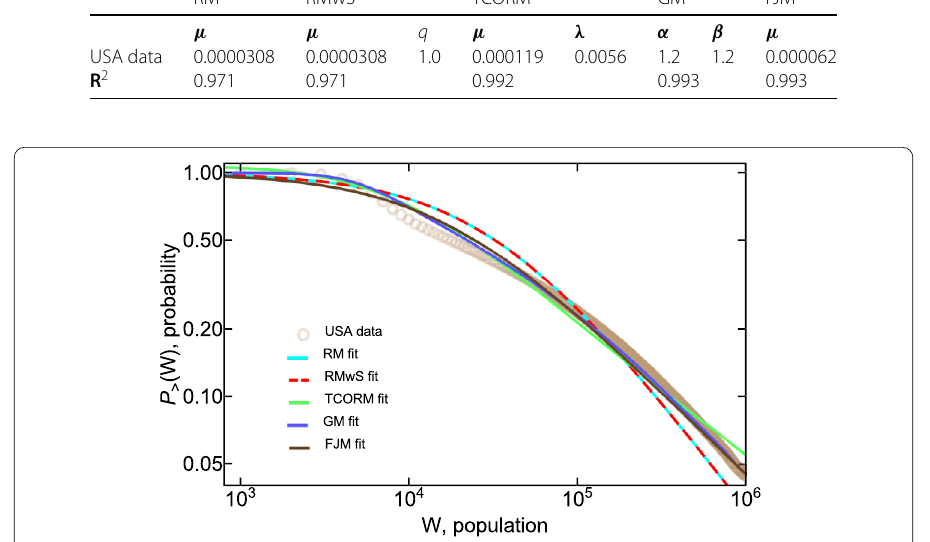
Figure 4 Comparison between the models prediction with experimental data for USA. Brown circles represent the calculated P > ( W ) values for USA using the census data between 2006 and 2010. These results are visually compared with the best fits obtained for the RM model (Eq. (6)), GM model (Eq. (3)) RMwS model (Eq. (7)), TCORM model (Eq. (8)) and FJM model (Eq. (16)). Logarithmic scales are used in order to better illustrate deviations from experiments at all scales. The best fit parameters are given in Table